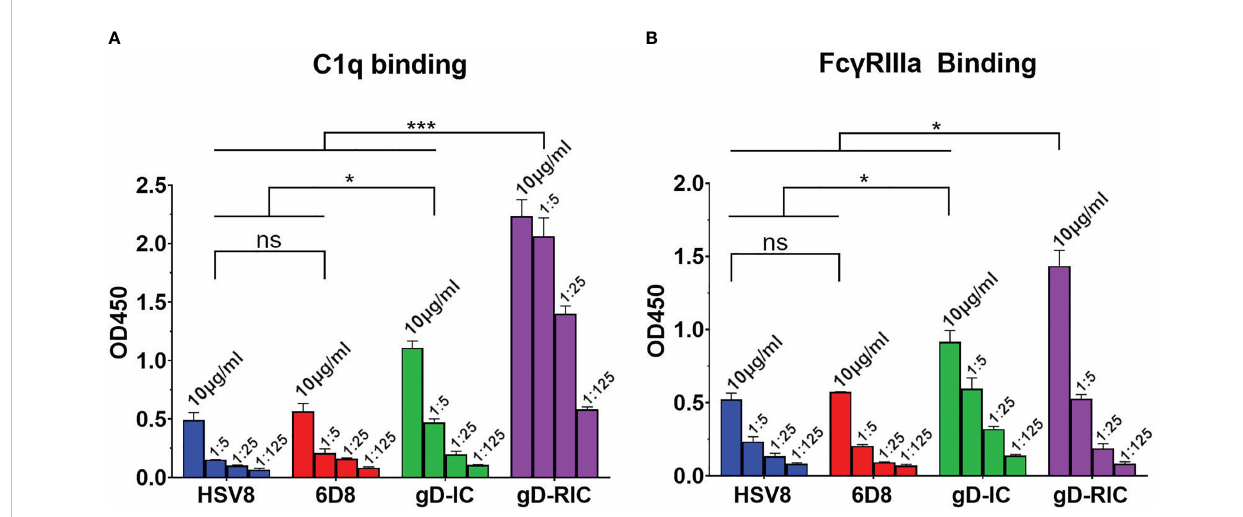
FIGURE 4 C1q and FcyRIIIa binding. Immune receptor binding ELISA of gD-IC and gD-RIC. ELISA plates were coated with 15 m g/ml (A) human C1q and (B) human FcyRIIIa and incubated with 5-fold serial dilutions of each construct starting at 10 m g/ml, using HSV8 and 6D8 mAbs as monomeric controls. Constructs were detected using polyclonal goat anti-human IgG-HRP. Mean OD450 values from three samples are shown ± standard error. Three stars (***) indicates p < 0.001 and one star (*) indicates p < 0.05 between the indicated columns using one-way ANOVA with Tukey ’ s post-test for multiple comparisons. ns, not signi fi